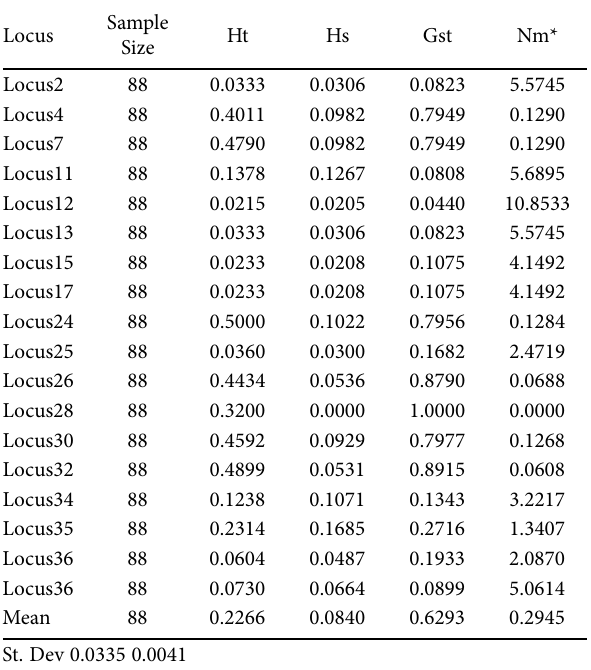
Table 4. Discriminating power of ISSR loci studied in P. afar popu-